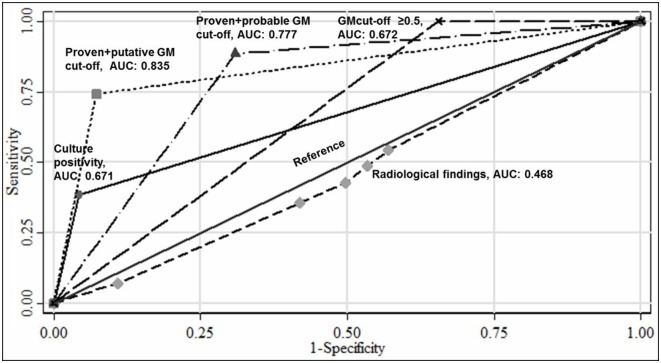
Predictor markers of mortality (using the final outcome as the reference).